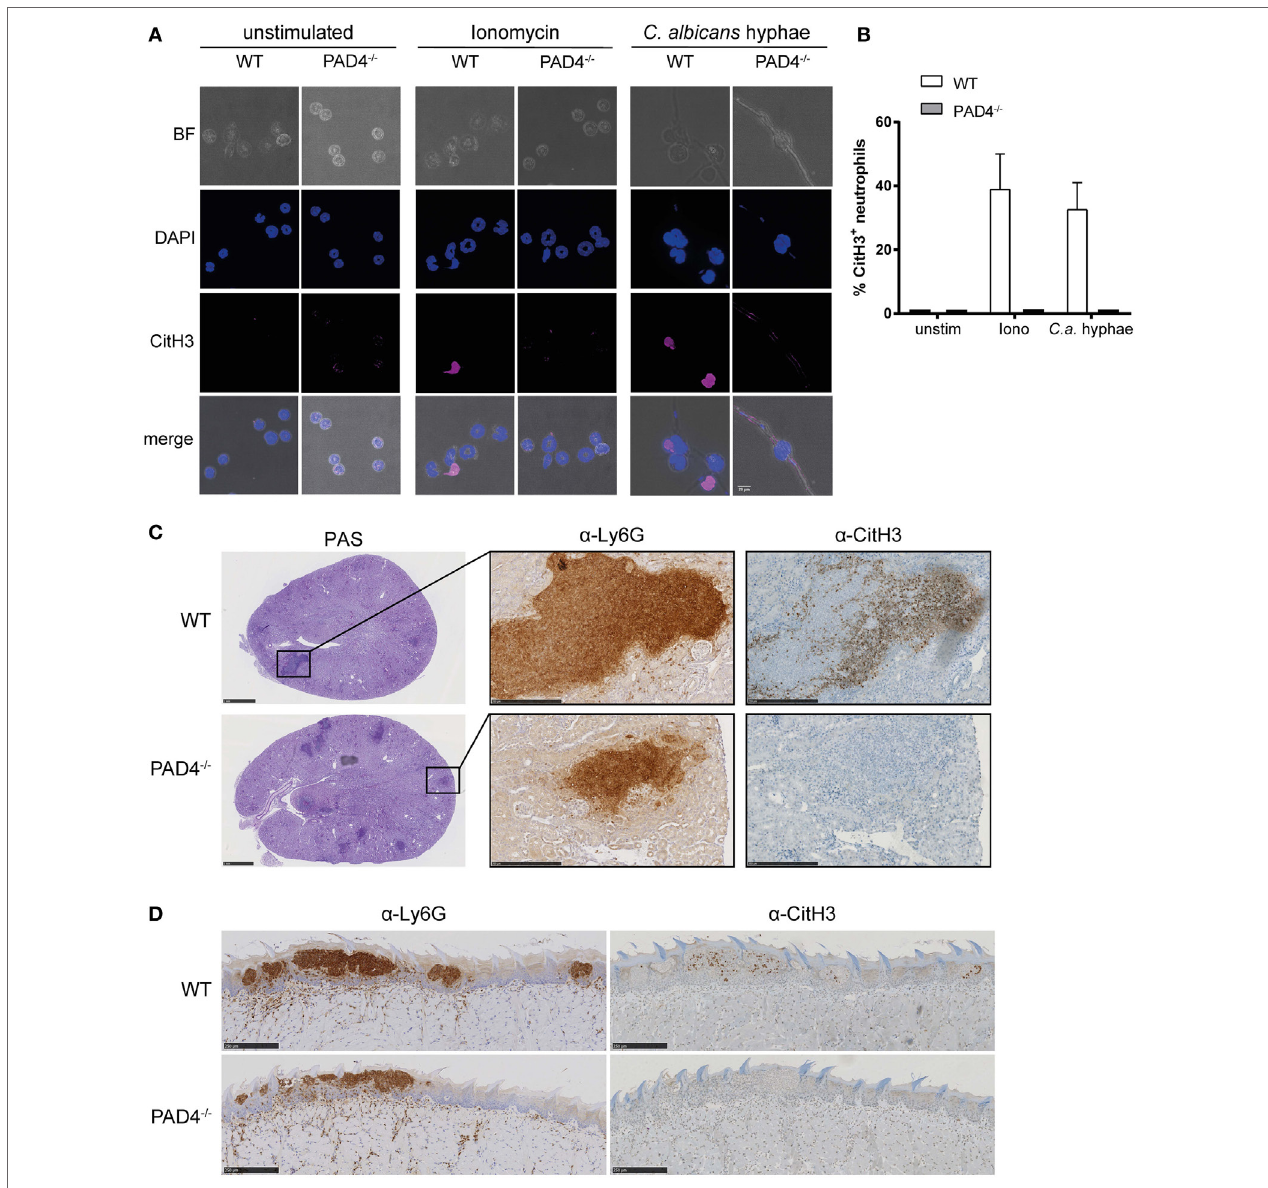
FigUre 1 | Candida albicans induces peptidylarginine deiminase 4 (PAD4)-mediated citrullination of histone H3. (a,B) Bone marrow neutrophils from WT and PAD4 − / − mice were stimulated for 2.5 h with C. albicans hyphae or ionomycin or left unstimulated and then stained for DNA (DAPI; blue) and citrullinated histone H3 (magenta); brightfield. Images were acquired by confocal microscopy (a) and the fraction of CitH3 + neutrophils was determined (B) . In (B) , the bars are the mean with standard error of the mean (SEM) of 10–30 cells analyzed per condition. (c,D) WT and PAD4 − / − mice were infected with C. albicans via the tail vein (c) or sublingually (D) . Consecutive kidney (c) or tongue (D) sections were stained with periodic-acid schiff reagent (c) , α -Ly6G or with α -CitH3 on day 3 postinfection (c) or on day 1 postinfection (D) , respectively. Representative images are shown. Scale bar = 50 µm [in (a) ], 1 mm [in (c) , left panel], 250 µm [in (c) middle and right panel and in (D) ]. See also Figure S1 in Supplementary